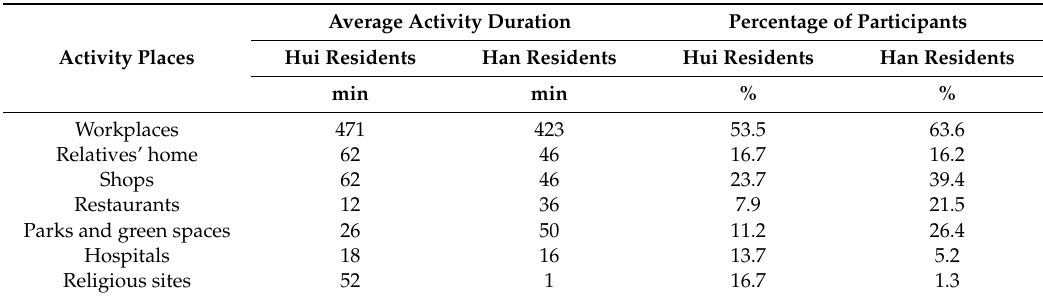
Table 5. Average activity duration in each type of activity place and percentage of participants that have at least once visited this type of activity